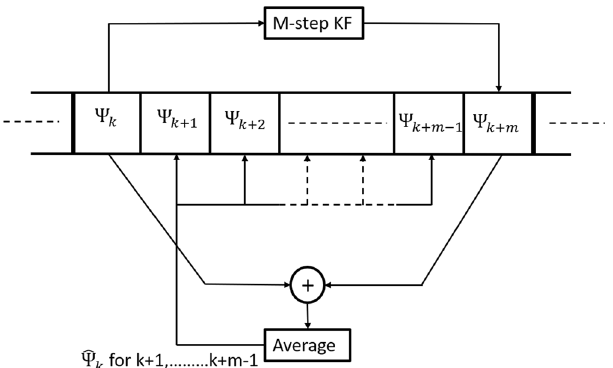
Figure 1. Principle of multi-step Kalman filter algorithm. Here m denotes the step size of the